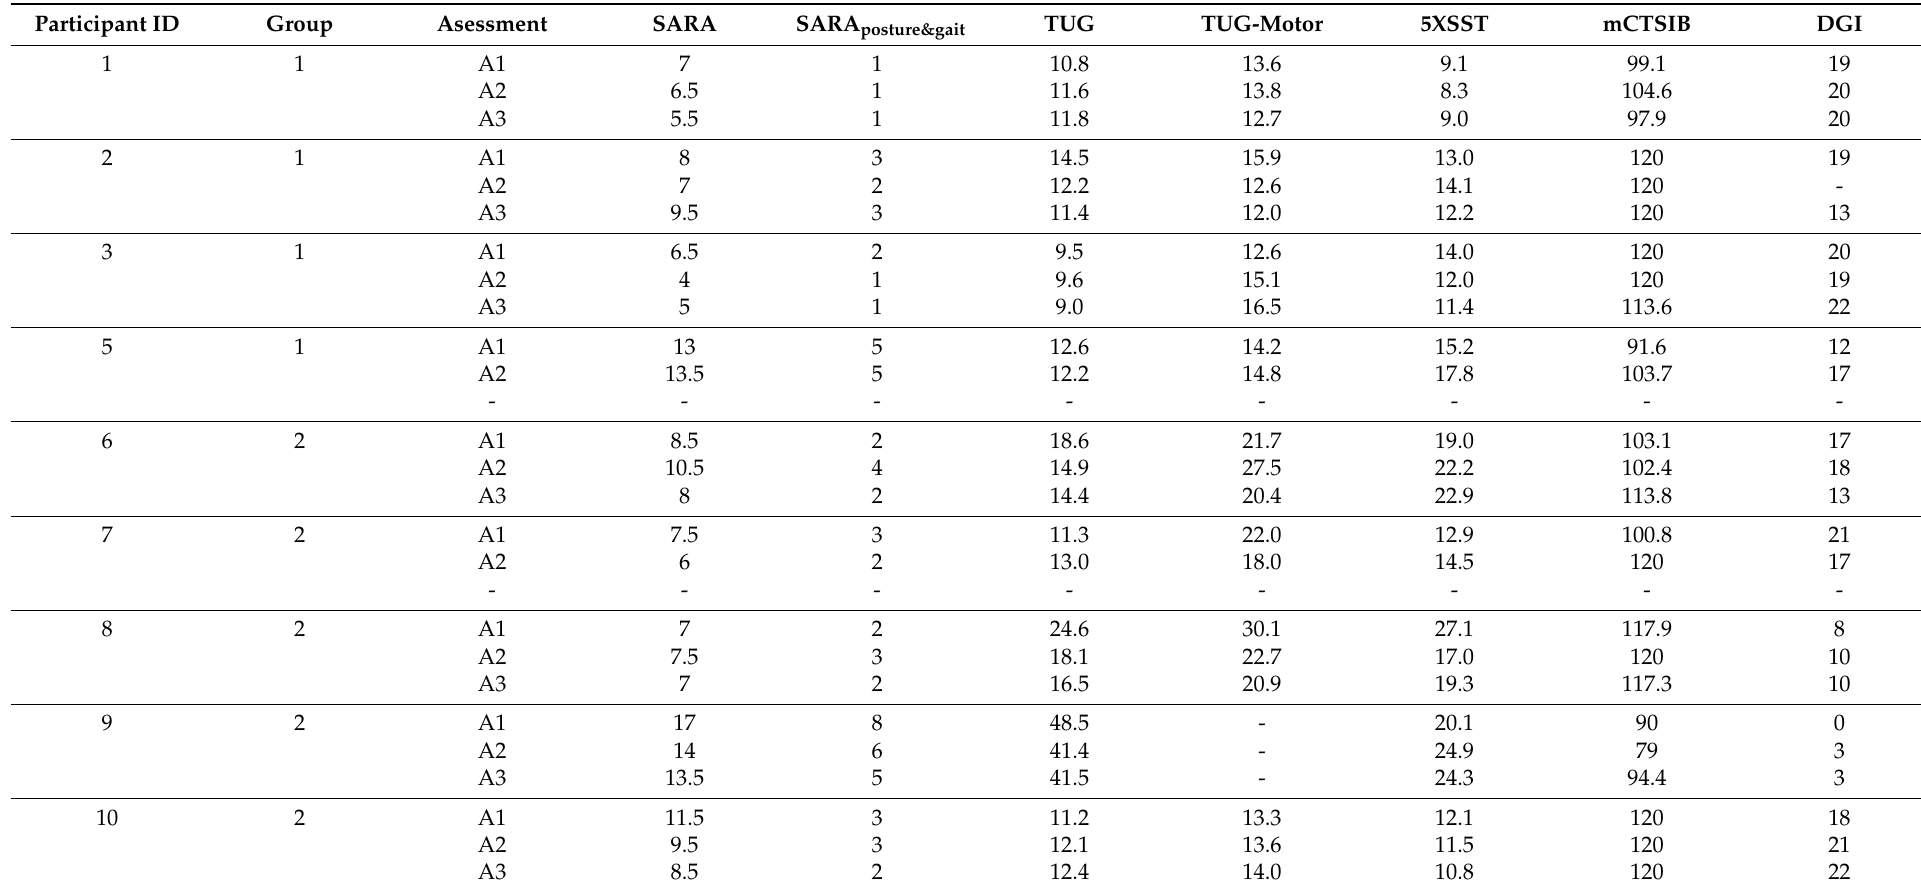
Table 5. Participant clinical outcome measures for A1, A2, and A3 assessments. Participants in Group 1 received vibrotactile SA during the first six weeks of training (between A1 and A2). Participants in Group 2 received vibrotactile SA during the second six weeks of training (between A2 and